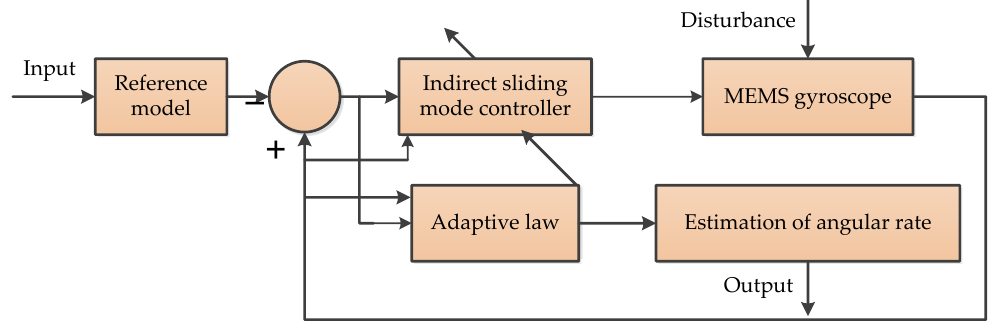
Figure 21. The principle of the adaptive sliding mode controller [82].